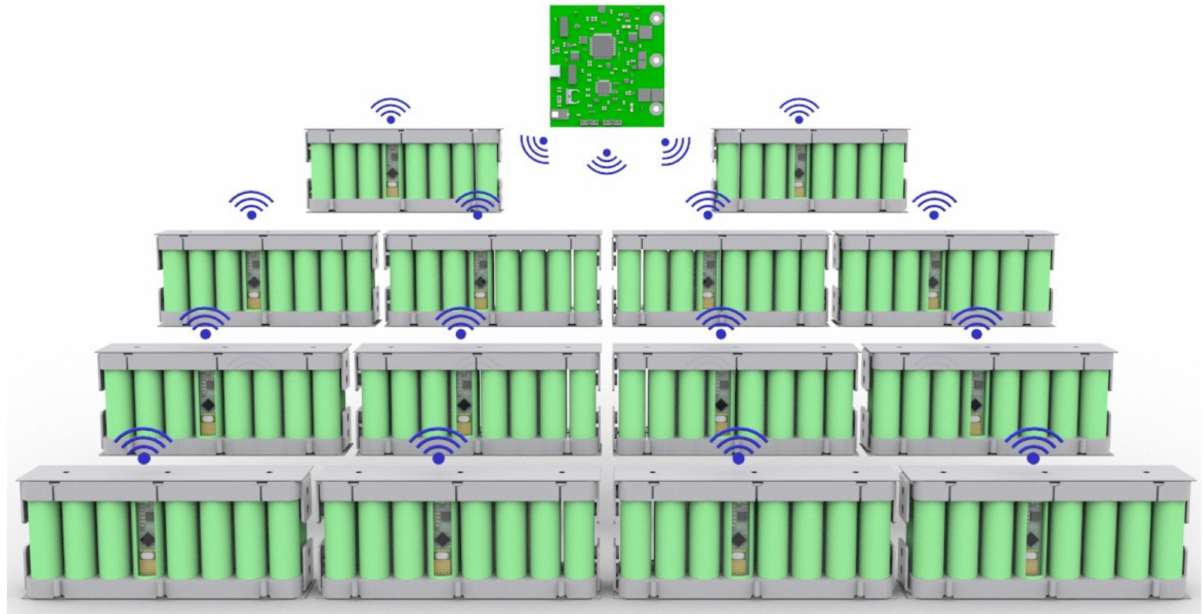
Figure 3. Concept of Modular Battery Management System with wireless